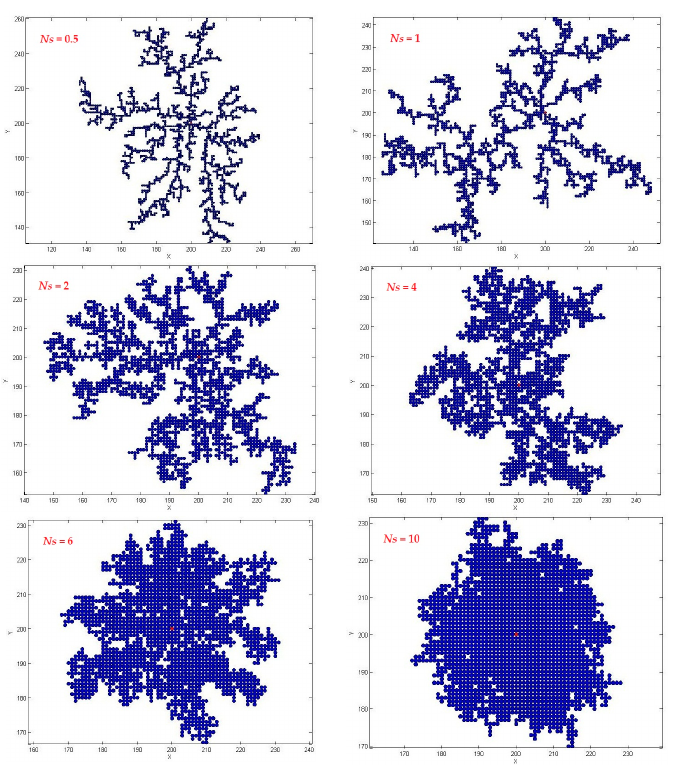
Figure 5. 2D DLA aggregates with different motion step lengths.